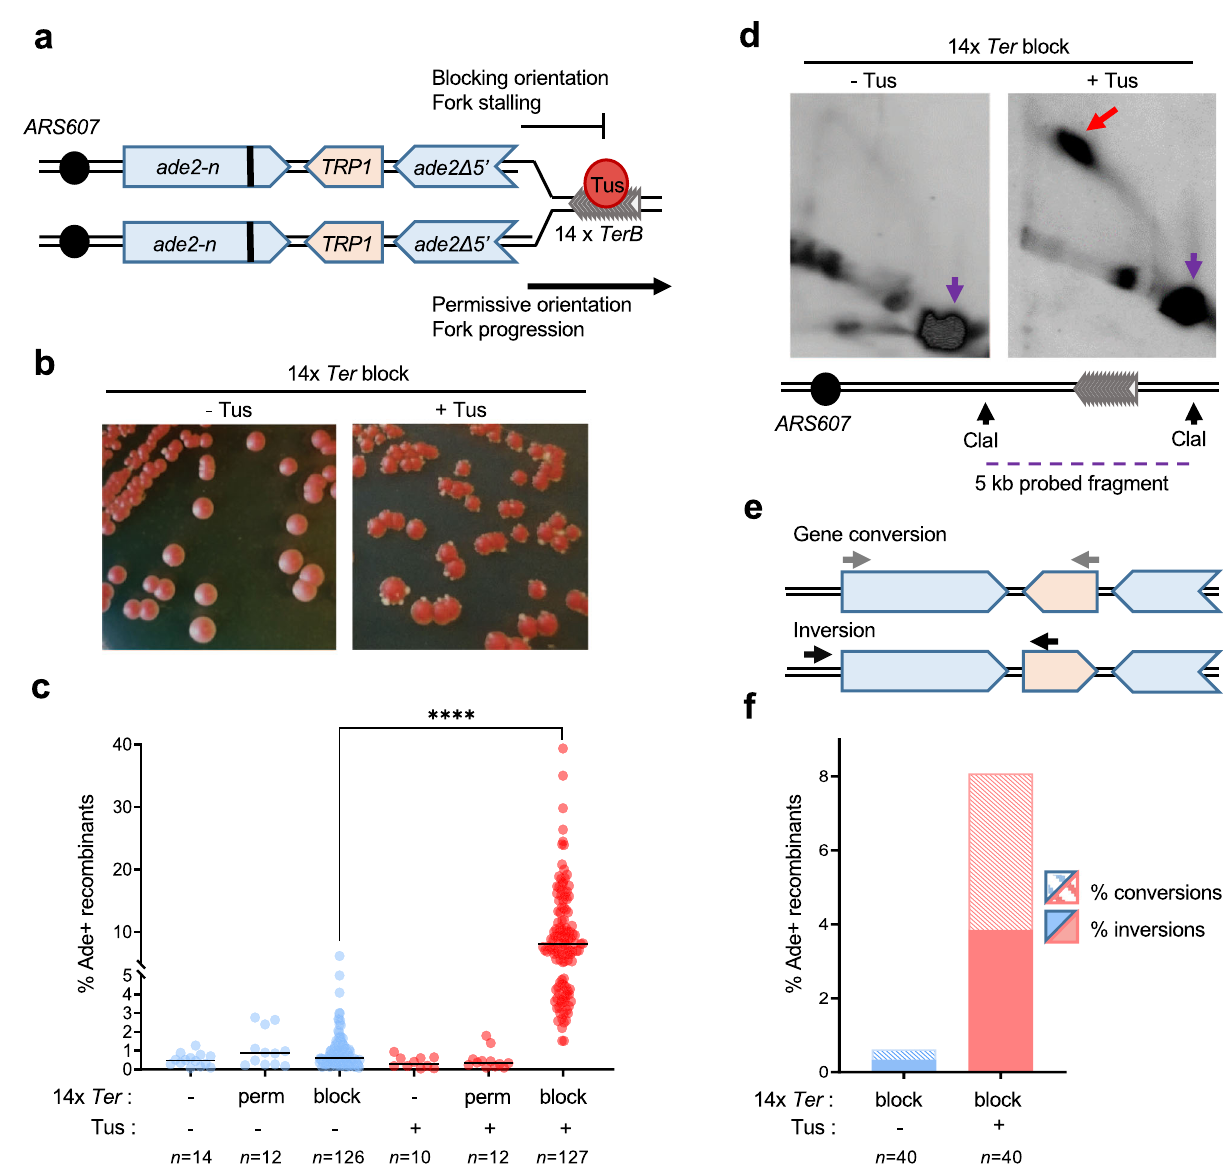
Fig. 1 A localized fork stalling barrier stimulates NAHR. a Schematic of the ade2 reporter and Tus/ Ter barrier in the blocking or permissive orientation with regards to ARS607 . The bold line indicates the + 2 frameshift mutation. b Colonies form more white sectors and papillae (indicative of Ade + phenotype) when Tus expression is induced. c Frequency of Ade + recombinants without (blue data points) and with (red data points) induction of Tus expression in strains containing different Ter constructs (Supplementary Table 1). Black lines indicate medians. p -values were obtained on log-transformed data by one-way ANOVA with a Bonferroni post-test and are reported as stars when signi fi cant: **** p -value < 0.0001. Perm permissive orientation; block blocking orientation. n indicates the number of colonies tested. Exact p -values are reported in Supplementary Data 1. d Two-dimensional gel analysis of replication intermediates in the strain containing 14 Ter repeats in the blocking orientation, with or without induction of Tus expression (see Supplementary Fig. S1 for details of probes used). The red arrow indicates fork arrest along the Y-shaped replication arc, the purple arrow indicates the unreplicated fragment. e Ade + recombinants formed by gene conversion or by inversion of the TRP1 locus are distinguished by PCR using primers designated by gray or black arrows. Inversion events can have the wild type or + 2 frameshift site within the ade2 Δ 5 ’ allele and are not distinguished here. f Distribution of NAHR events for each condition. n indicates the number of independent Ade + recombinants tested. Data were analyzed by Chi-square test and exact p -values are reported in Supplementary Data 1. Source data are provided as a Source Data fi